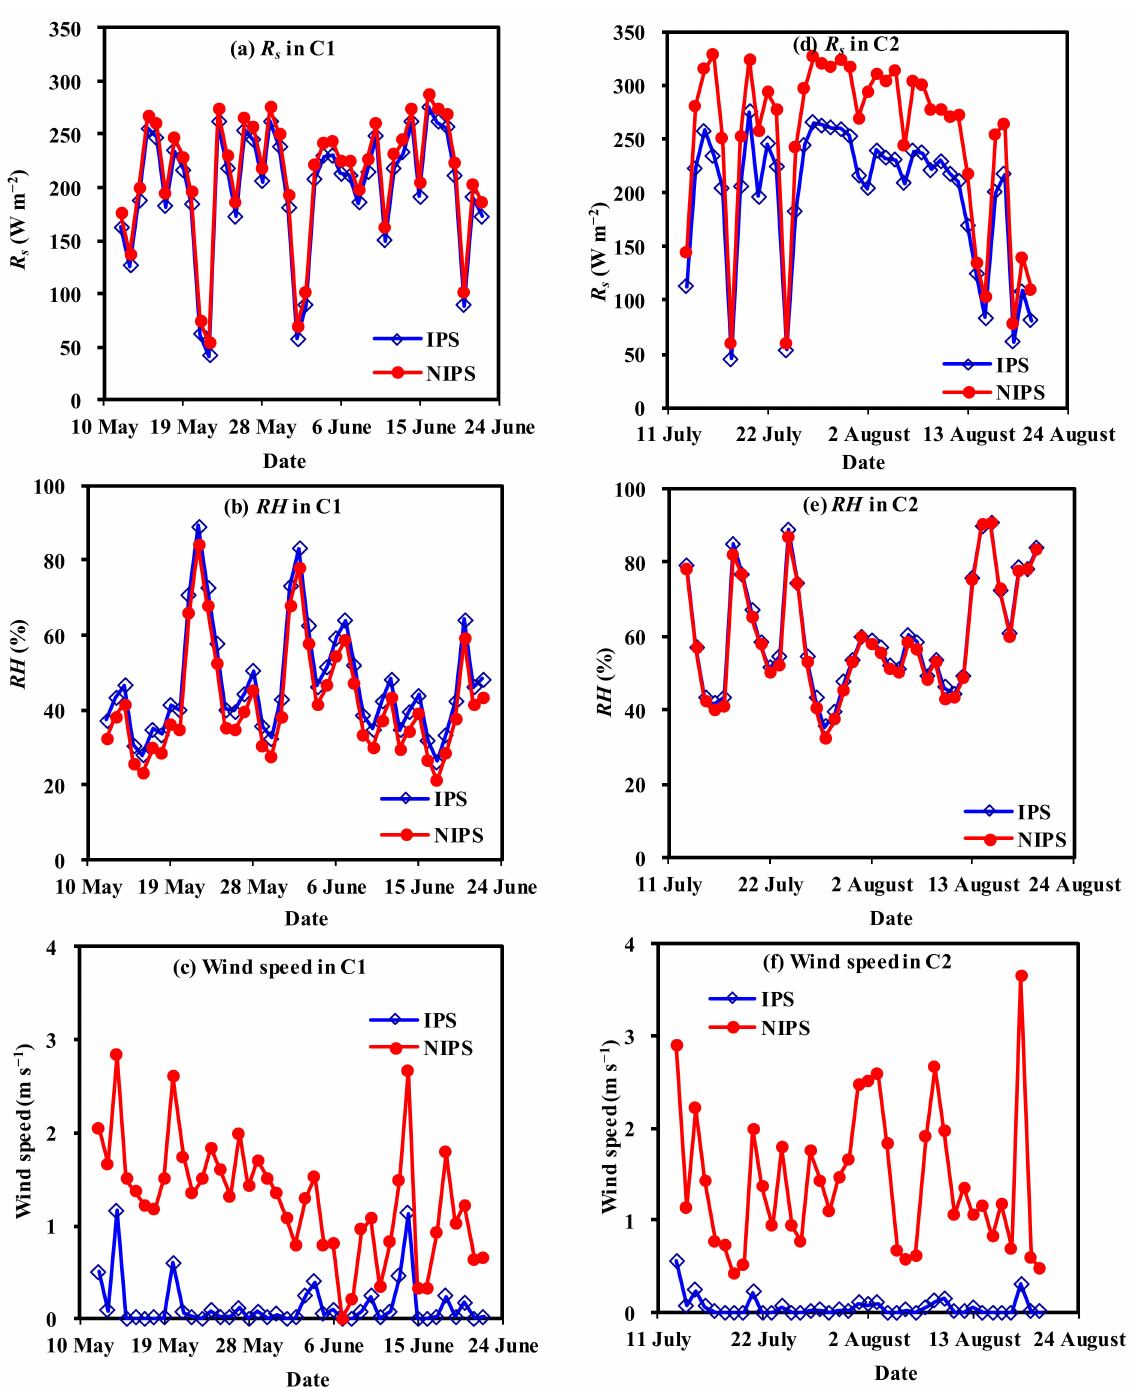
Figure 2. Effects of IPS on ( a , d ) daily solar radiation ( R s) , ( b , e ) air humidity ( RH ), and ( c , f ) wind